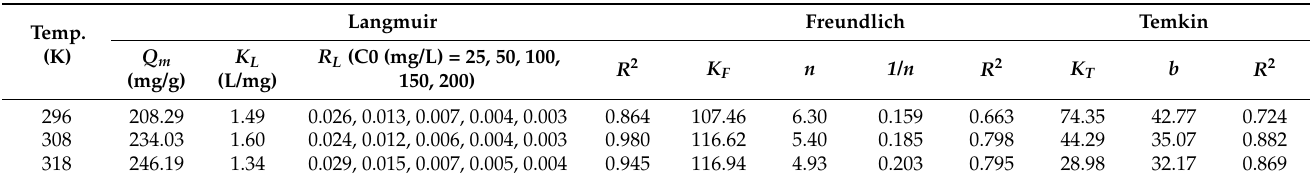
Figure 11. Langmuir, Freundlich, and Temkin plots for CV adsorption onto ZFAC. Bars represent the standard error of the mean ( n = 2). Table 2. Langmuir, Freundlich, and Temkin isotherm parameters for CV adsorption onto